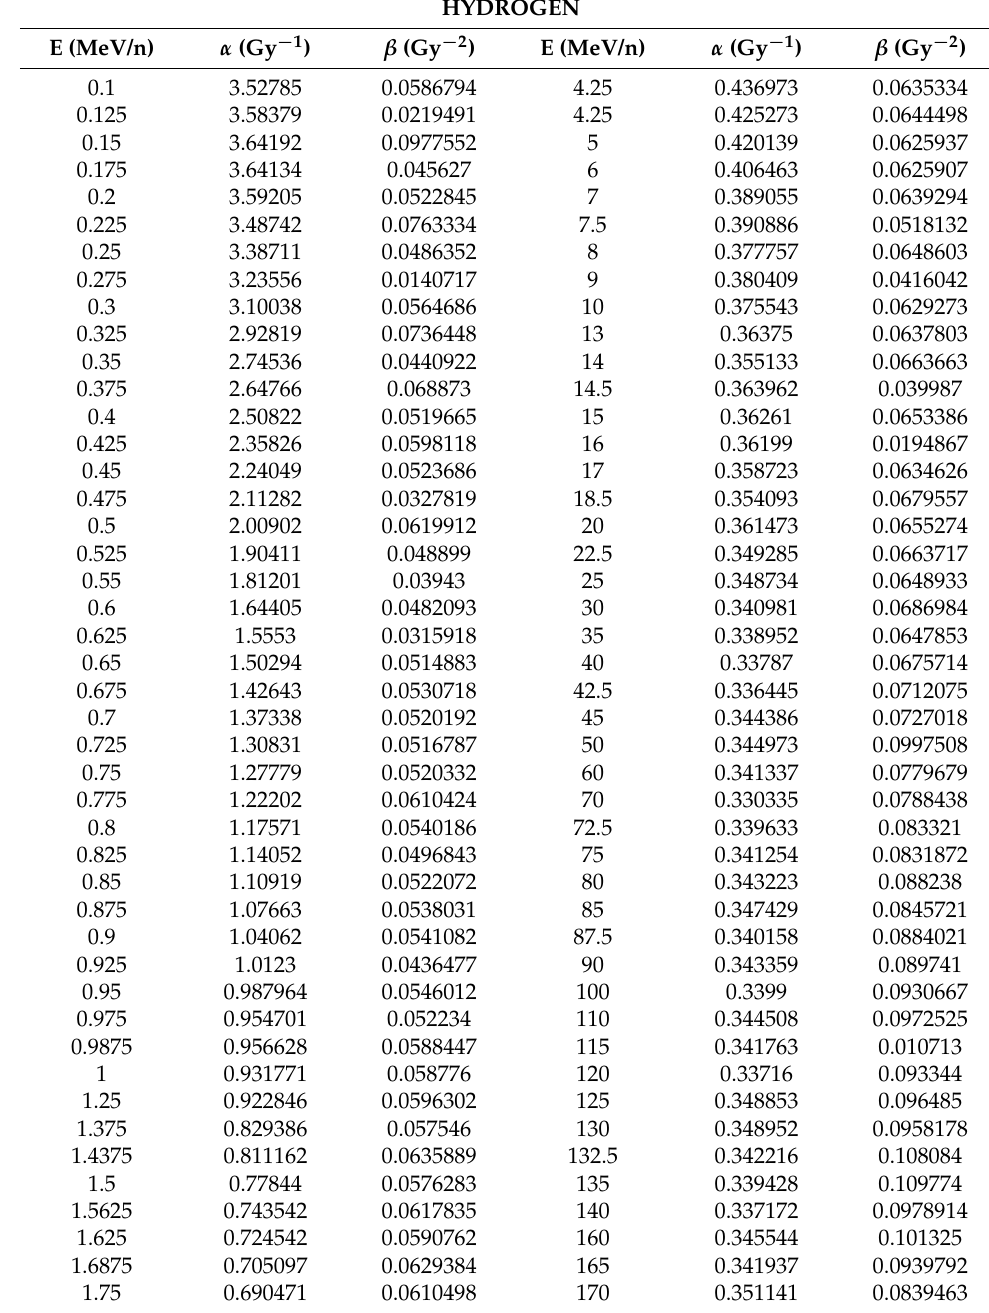
Table A1. Predictions of α and β Values for the HSG Cell Line in Response to Hydrogen, Helium, Carbon, Oxygen and Oxygen Ions for the NanOx